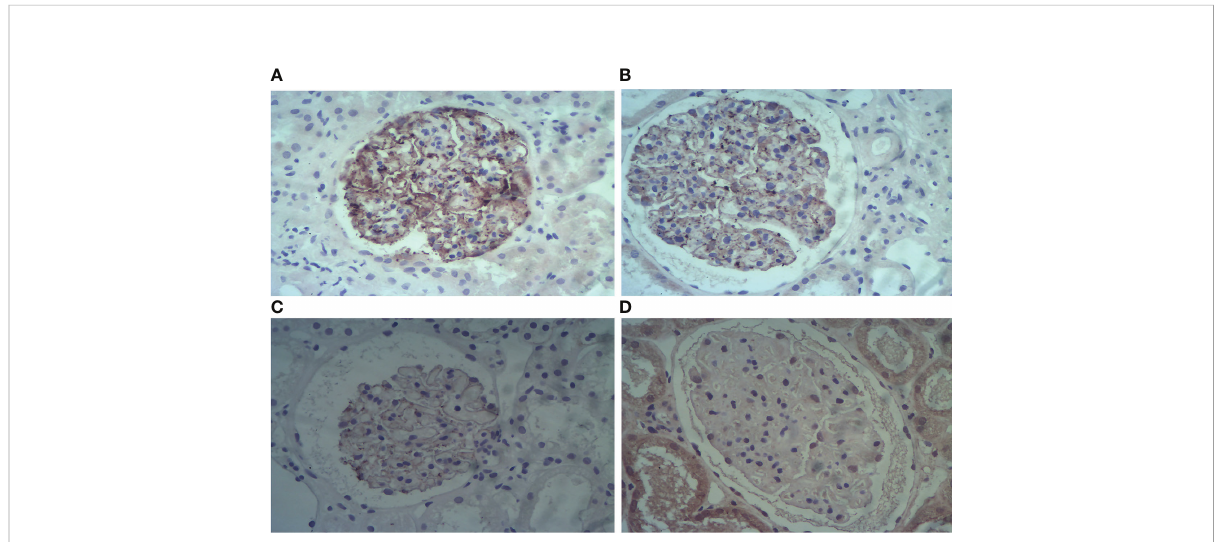
FIGURE 1 Representative images of positive glomerular PLA2R staining in case 5 (A) and positive THSD7A staining in case 5 (B) and case 6 (C) as determined by immunohistochemistry. Negative glomerular NELL-1 staining in case 2 (D) . (Immunohistochemistry staining, magni fi cation